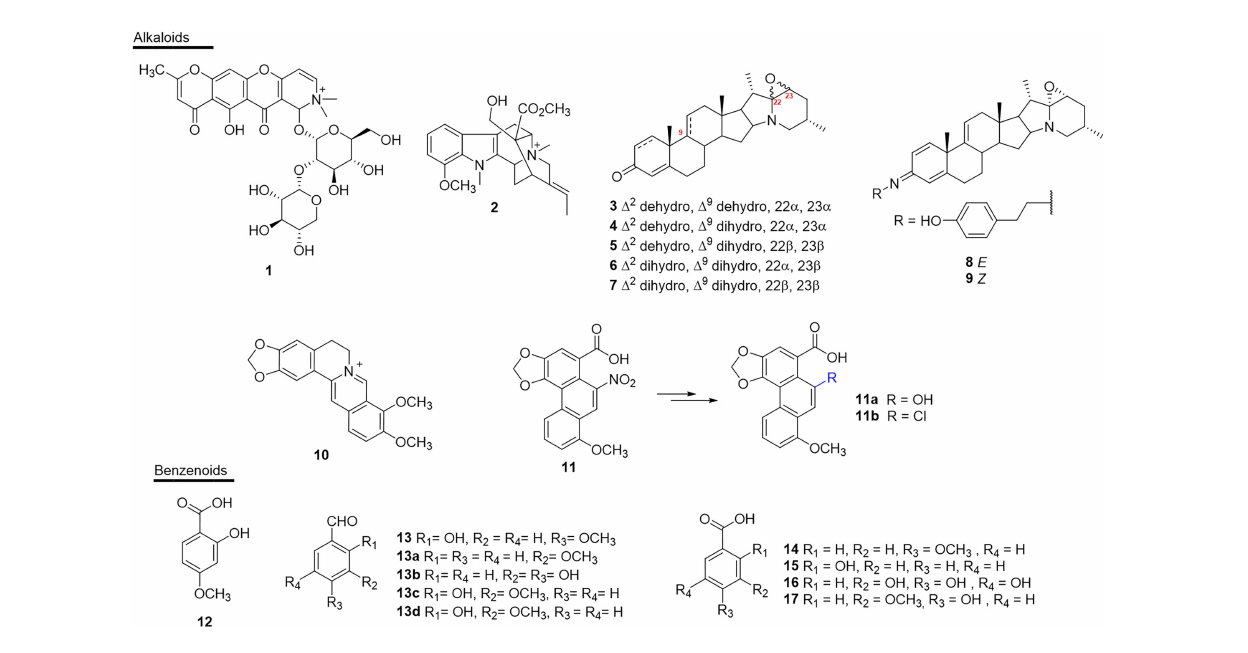
FIGURE 4 | Chemical structures of snakebite treatment compounds 1-17